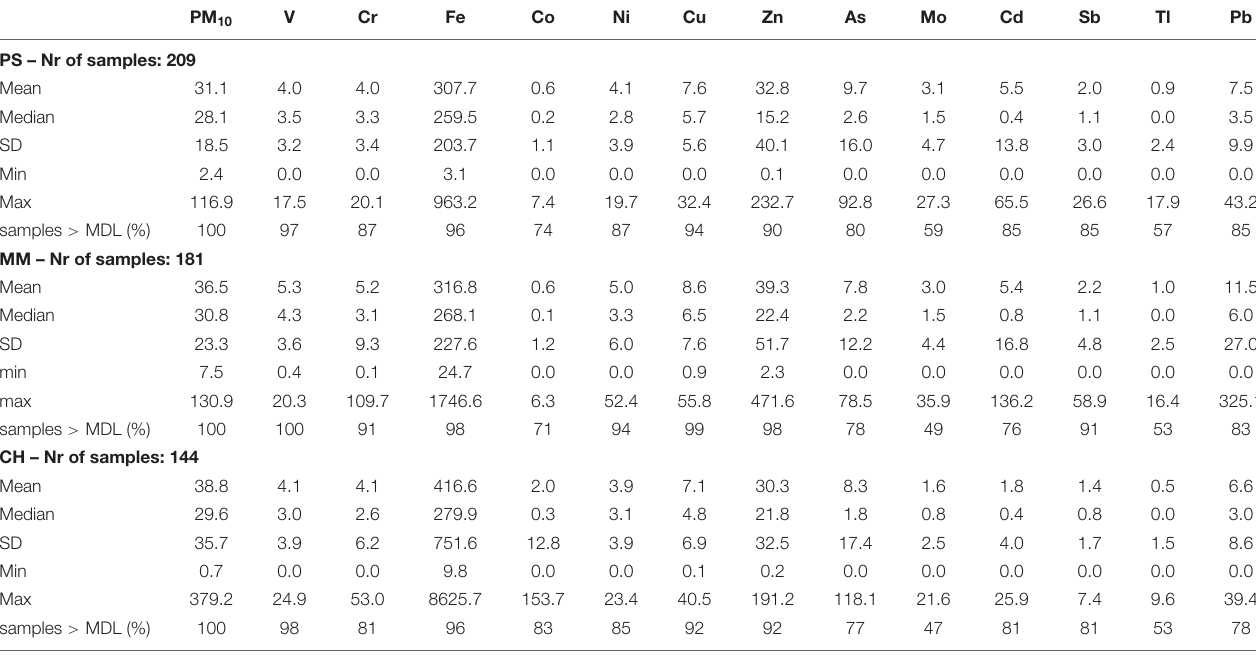
TABLE 2 | Coefficients of divergence between the three